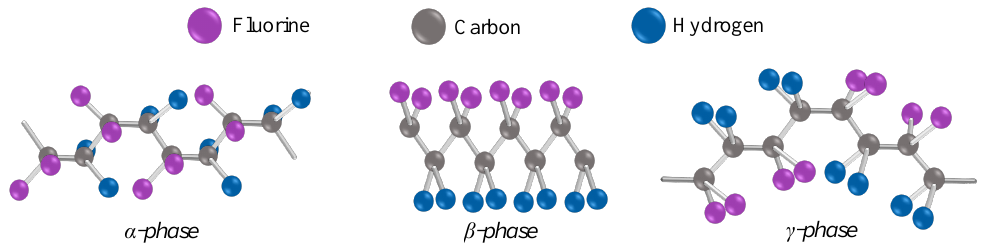
Figure 1. The chain conformation of the most observed phases in PVDF [17]. Because the fluorine atoms in the β -phase are situated on the same side of the molecular chains, which are arranged parallel to one another in a specific direction, with the same dipole orientation and enhanced polarity, the β -phase exhibits spontaneous polarization strength as well as pyro- and piezoelectric properties [18]. Popular methods for phase characteristics are Fourier transform infrared spectroscopy (FTIR), Raman Spectroscopy, X-ray diffraction (XRD), and differential scanning calorimetry (DSC). These methods are discussed later in Section